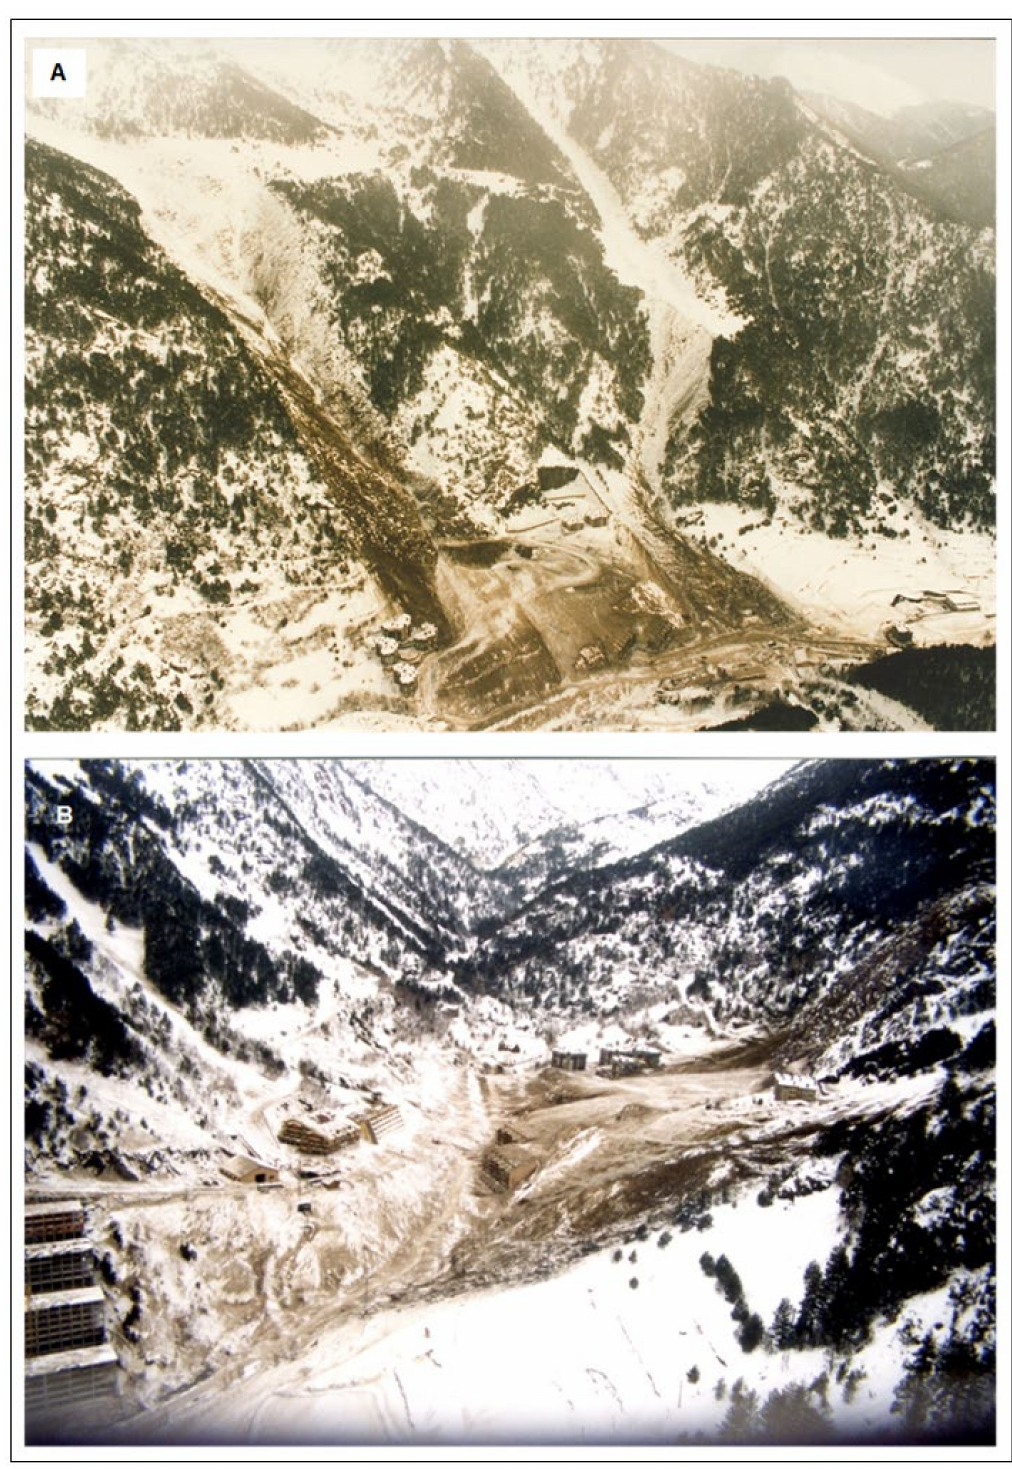
Figure 7. Photographs taken from a helicopter the day after the avalanche (Dept. d’Ind ú stria). ( A ) track and run-out zones of Les Fonts (left) and Percanela (right) avalanches; the LFd’A avalanche entrained the whole snowpack in the track zone, completely destroying the forest and partially eroding the soil; ( B ) run-out zone view from downstream to upstream in the main valley; the main aerosol trajectory direction can be observed in the plastered snow on the